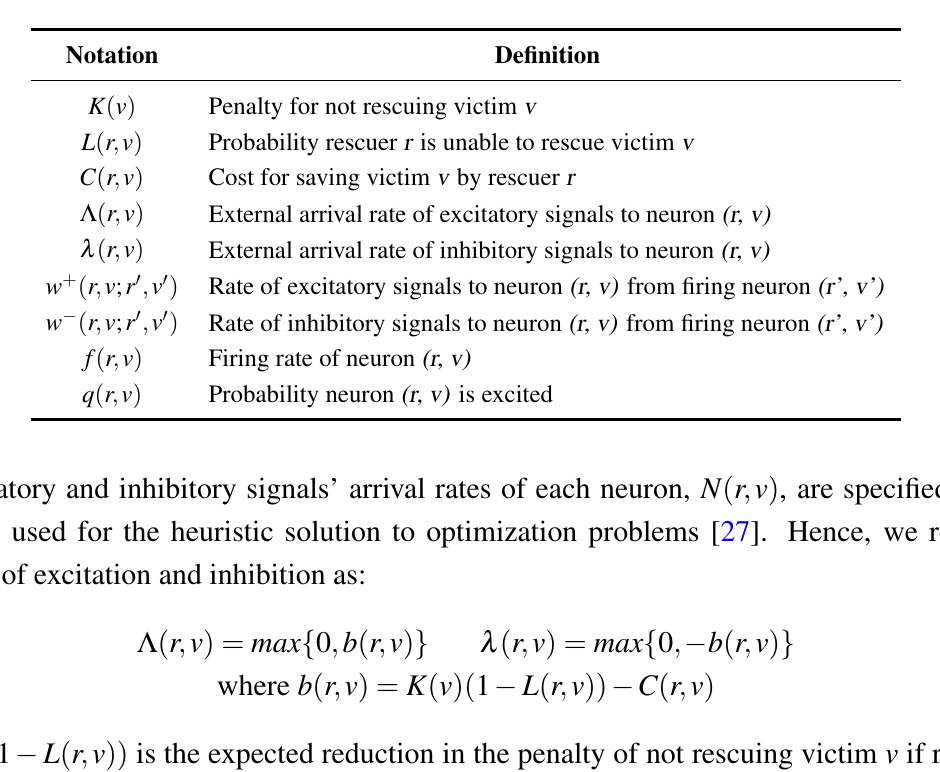
Table 2. List of RNN parameter association approach symbols